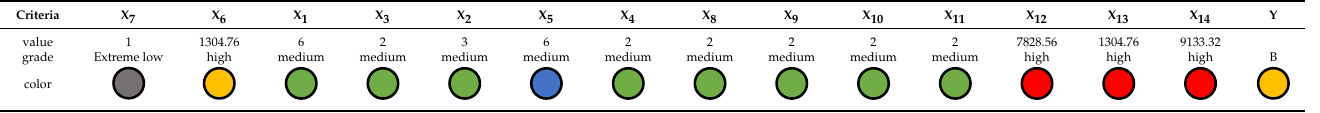
Table 3. Level and color assignment of variables.